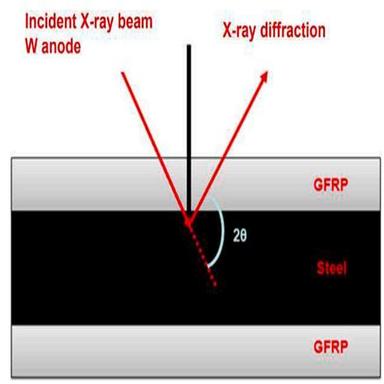
Schematic highlighting the procedure employed for residual stress measurement through ED-XRD in the GFRP/steel/GFRP samples.